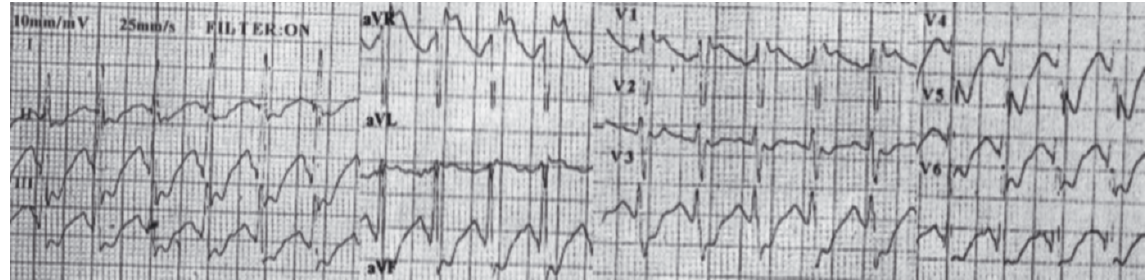
Figure 1. Case 1: Sinus tachycardia 150 beats/minute with ST segment depression (2-5 mm) in anterior and inferior leads, and ST segment elevation 1-3 mm in leads aVR, aVL, V1.